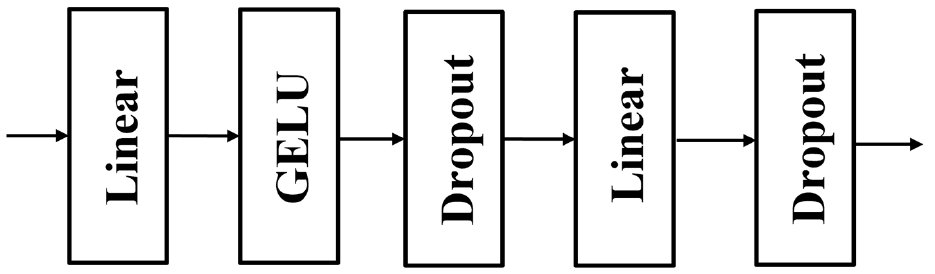
Figure 5. The internal structure of FFN.